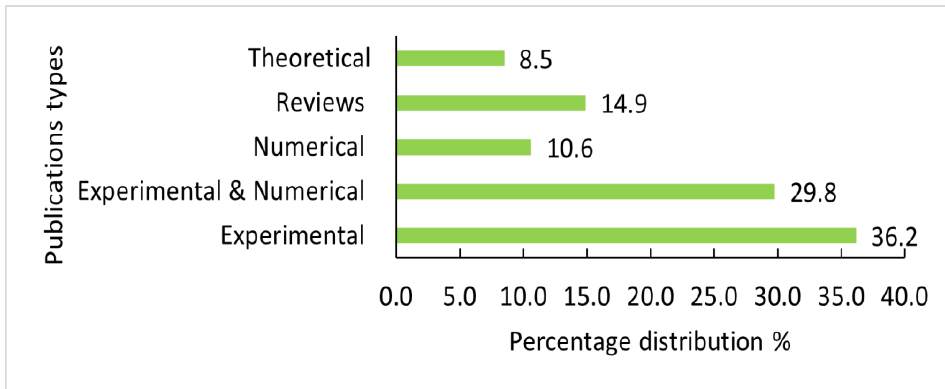
Figure 7. Publications distribution based on used approach.